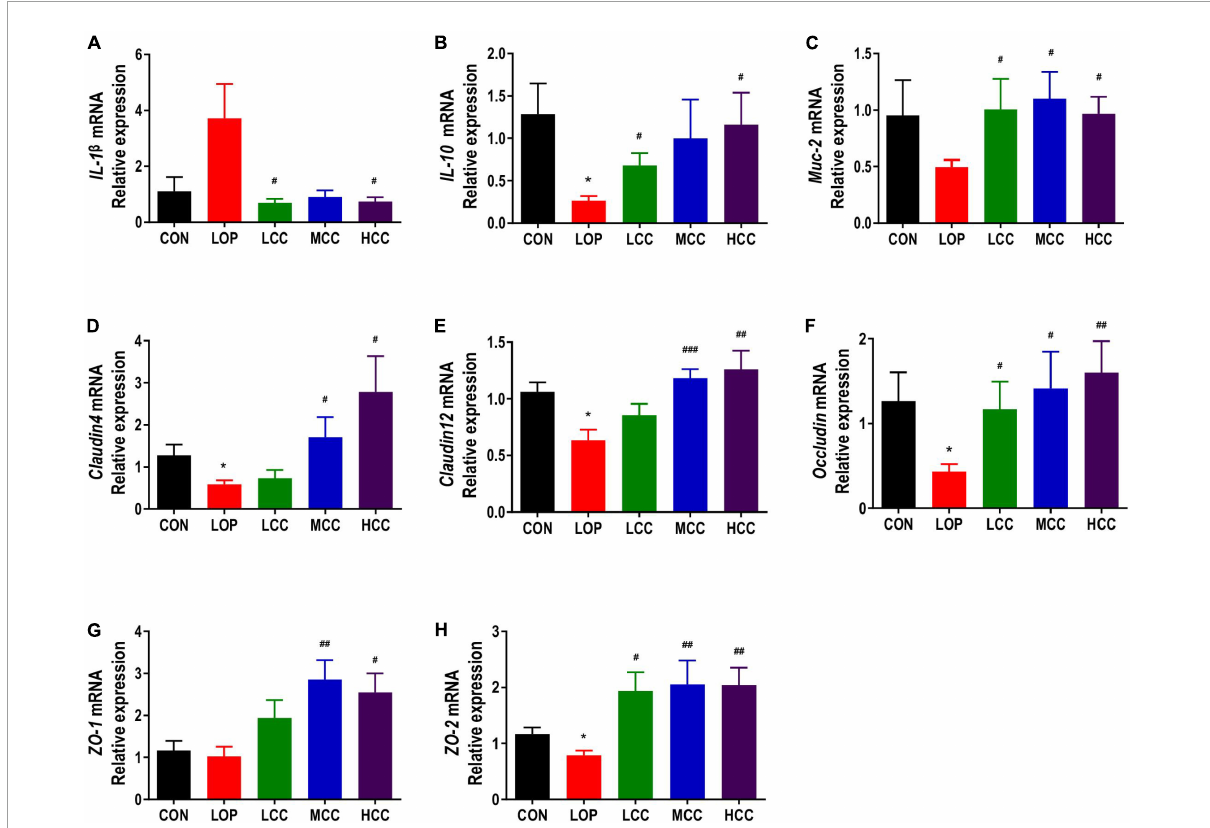
FIGURE4 Effects of CCAE administration on the mRNA expression of inflammation- and intestinal barrier-related factors in the colons of mice. (A–H) IL-1 β , IL-10 , Muc-2 , Cldn4 , Cldn12 , Occludin , ZO-1, and ZO-2 . The data are expressed as the means ± SEMs ( n = 8). *, Compared with the NCD group; #, compared with the LOP group. * P < 0.05, ** P < 0.01, *** P < 0.001. # P < 0.05, ## P < 0.01, ### P <